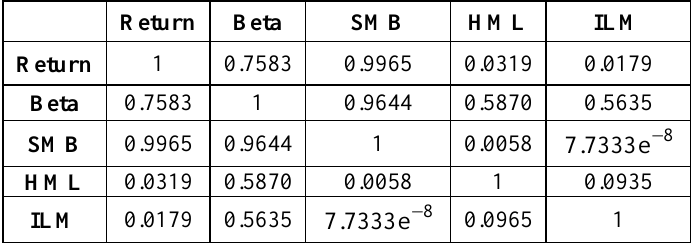
Table 2. The Probability of Significant Variables at the First